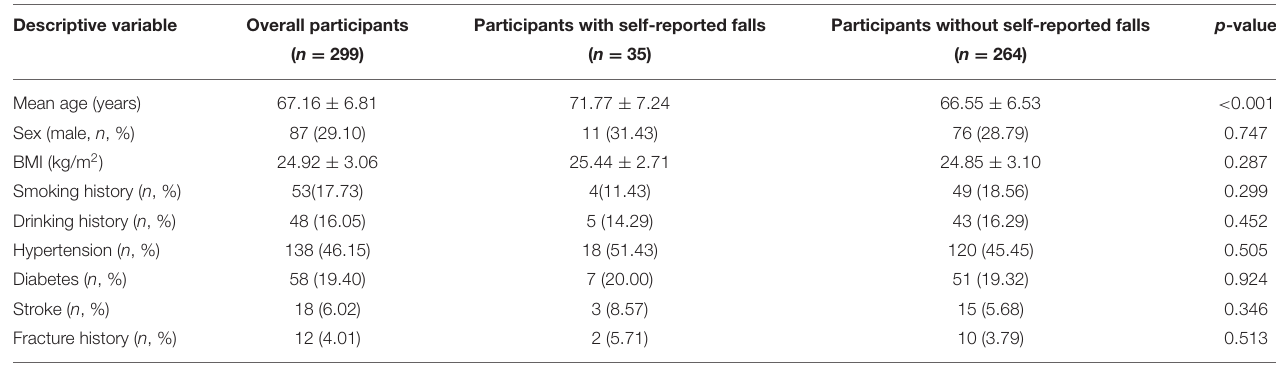
TABLE 1 | Demographic details in participants with and without self-reported